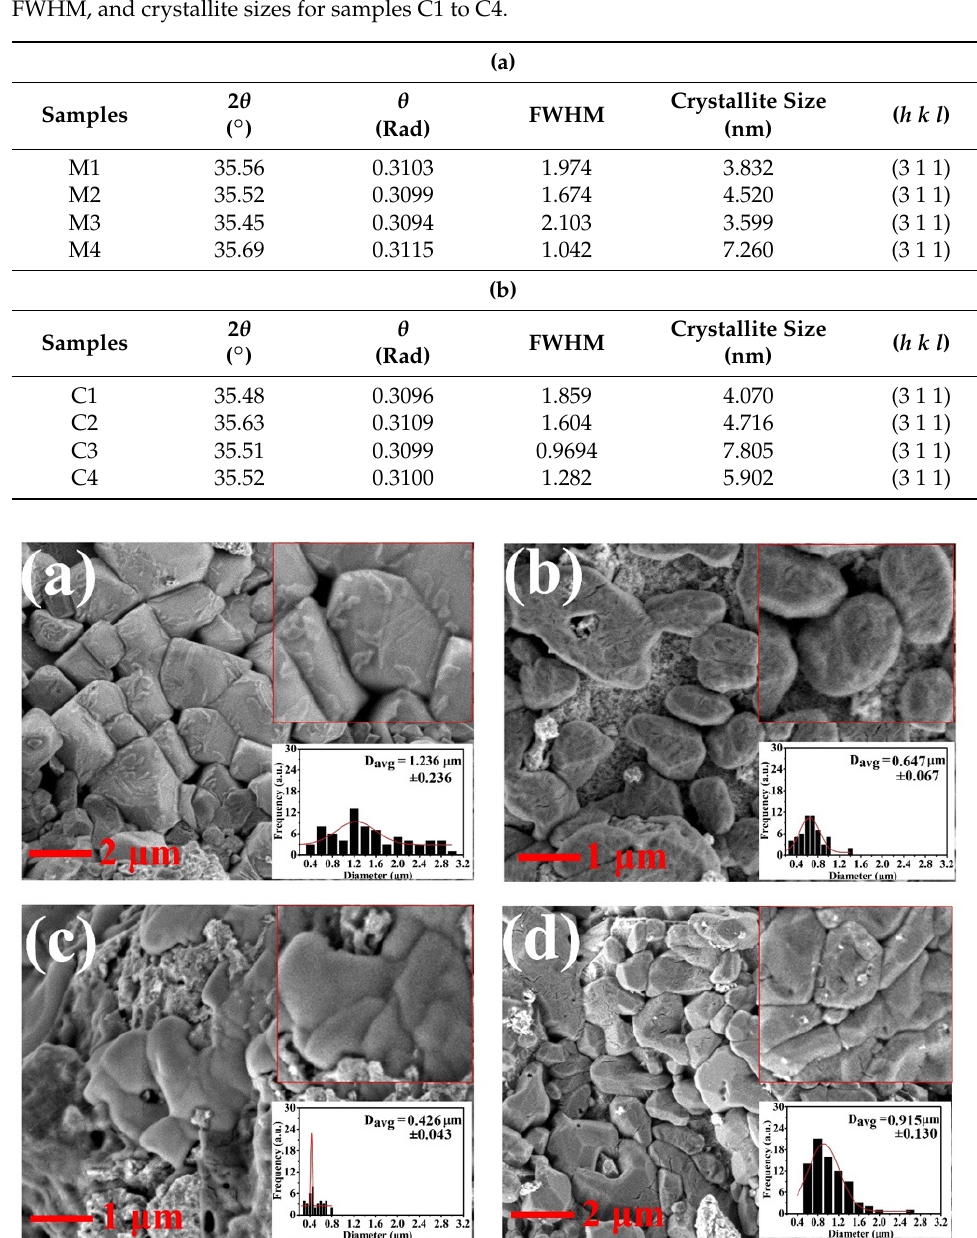
Figure 4. FESEM images of MNPs synthesised at increasing molarities: [( a ) M1; ( b ) M2; ( c ) M3; and ( d ) M4)].